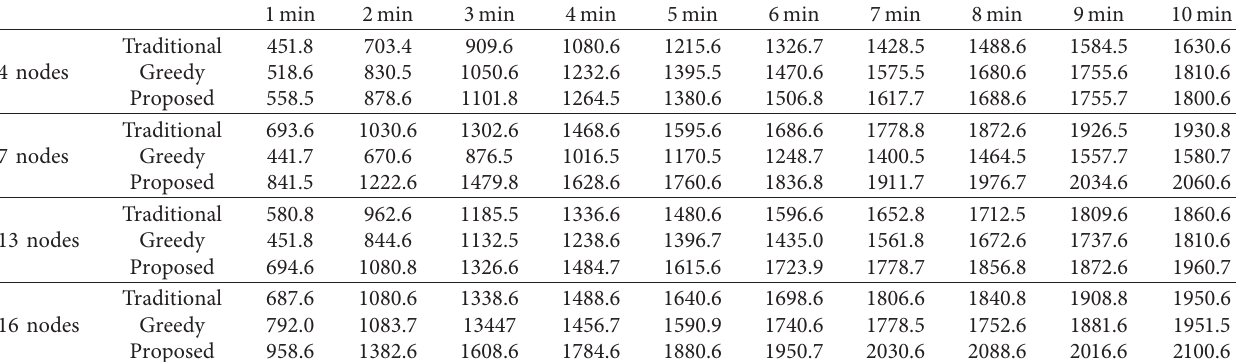
Table 2: Comparison results of different techniques (in terms of network